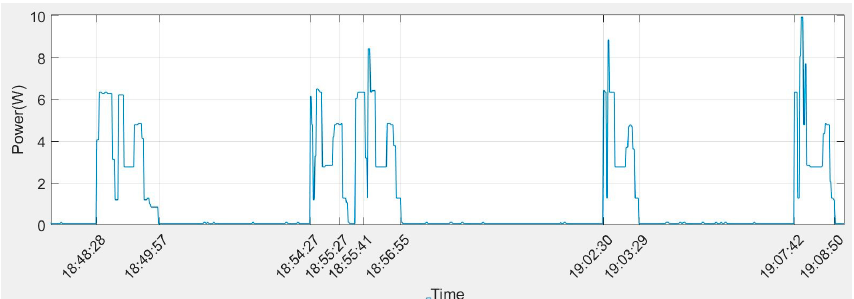
Figure 5. The power consumption when the refrigerator door is opened.